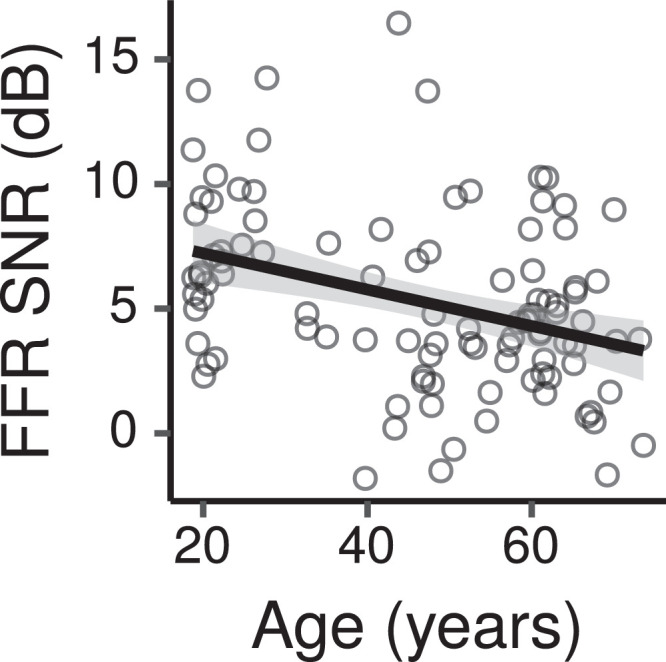
Across-montage average FFR TFS SNR by age. The figure shows a least squares line fit of FFR SNR by age with 95% confidence intervals as a visual aid. The slope for the effect of age estimated by the Bayesian multiple regression model is not the same as that shown in the figure.